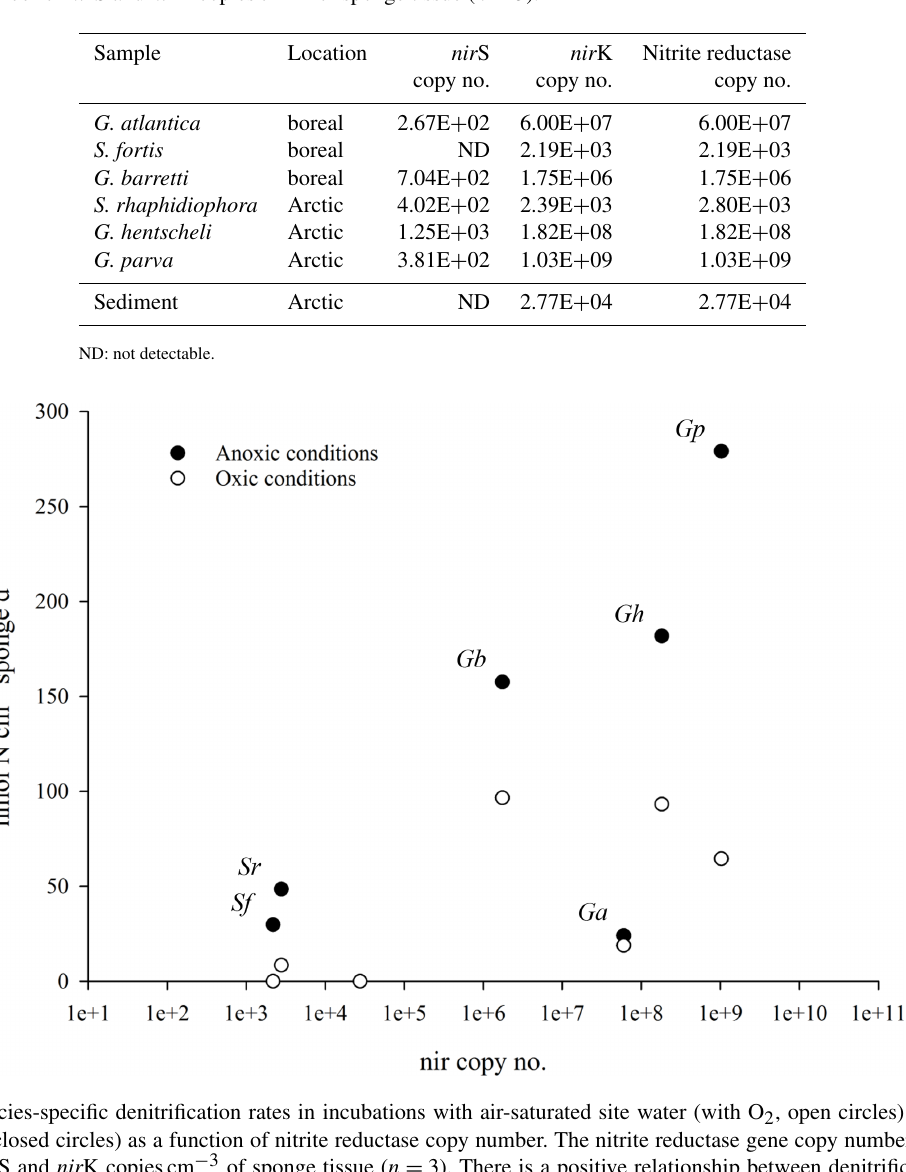
Table 2. Abundance of the nitrite reductase genes nir S and nir K in sponge and sediment samples. The nitrite reductase copy number is the